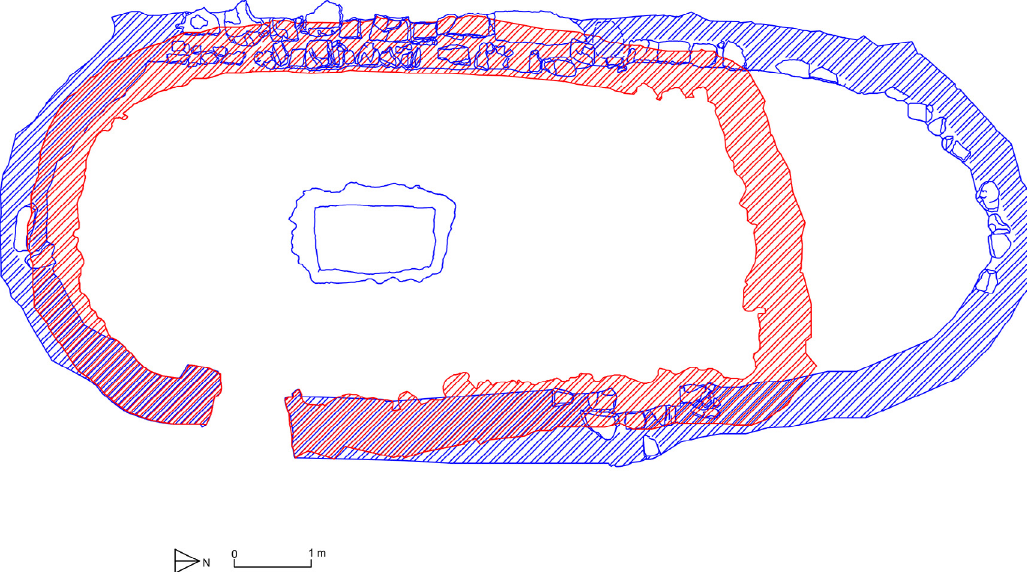
Figure 3. Calicantone. The two phases hut.